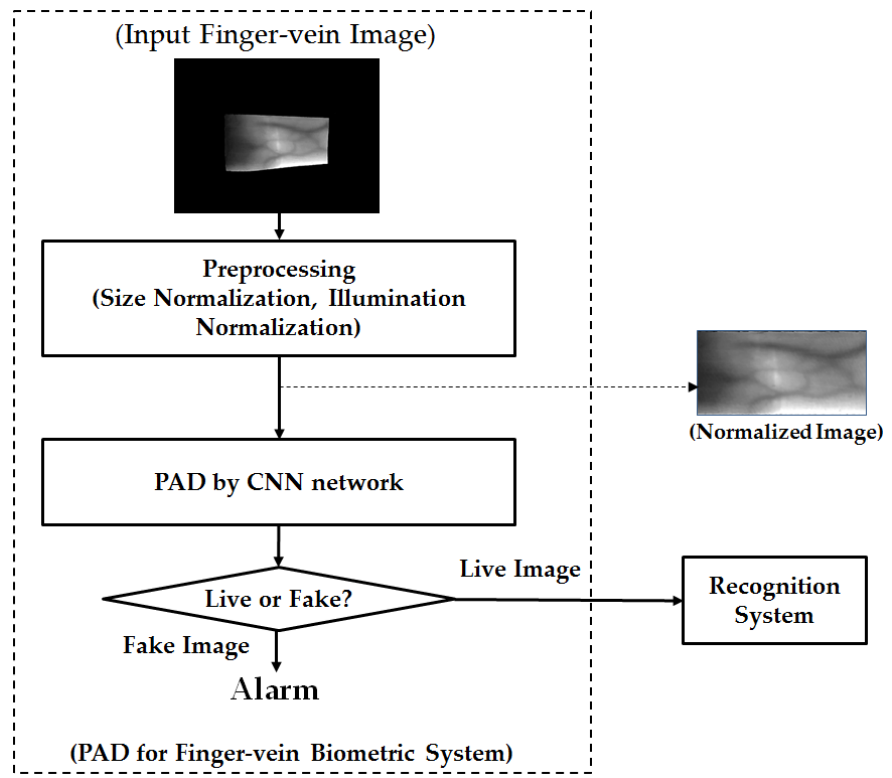
Figure 6. Overall procedure of CNN-based PAD method for finger-vein recognition system.